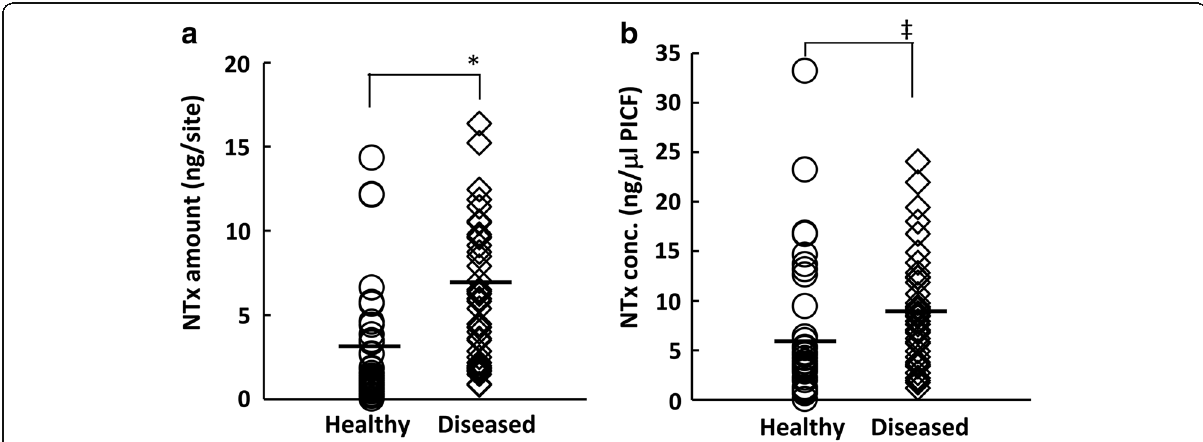
Fig. 2 Comparison of NTx levels in PICF. NTx amounts ( a ) in PICF samples from peri-implant disease sites ( n = 40, diseased) and non-diseased sites ( n = 34, healthy) were measured by ELISA, and its concentration ( b ) was normalized by the volume of PICF. Horizontal bars show the mean values of each group. ‡ P < 0.05, * P <